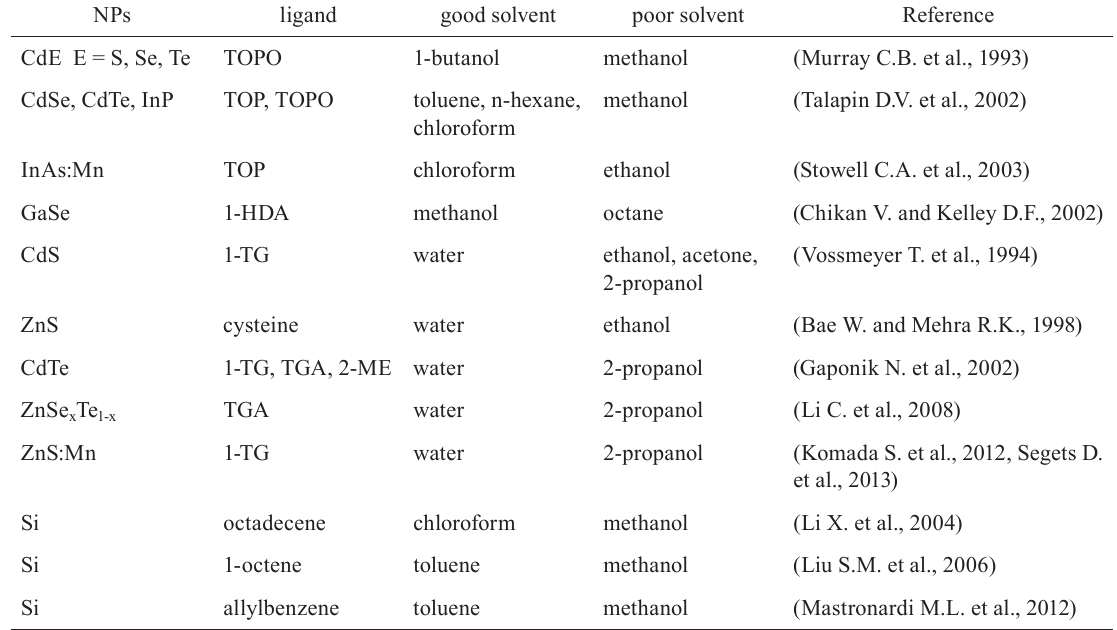
Table 3 Report of SSP using poor solvent